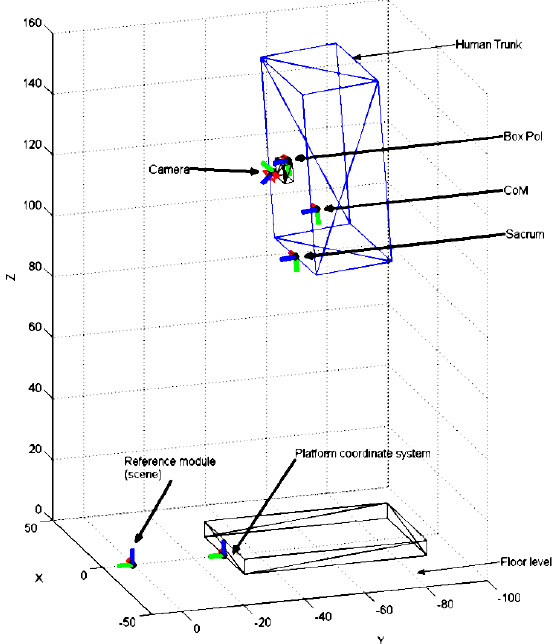
Figure 2. Illustration of the various frame coordinates used in Equimetrix to estimate CoM po- sition with respect to a reference frame (“scene”). The blue box represents the subject’s trunk, while the Box PoI stands for “Point of Interest” and corresponds to a particular location on the casing holding the camera.